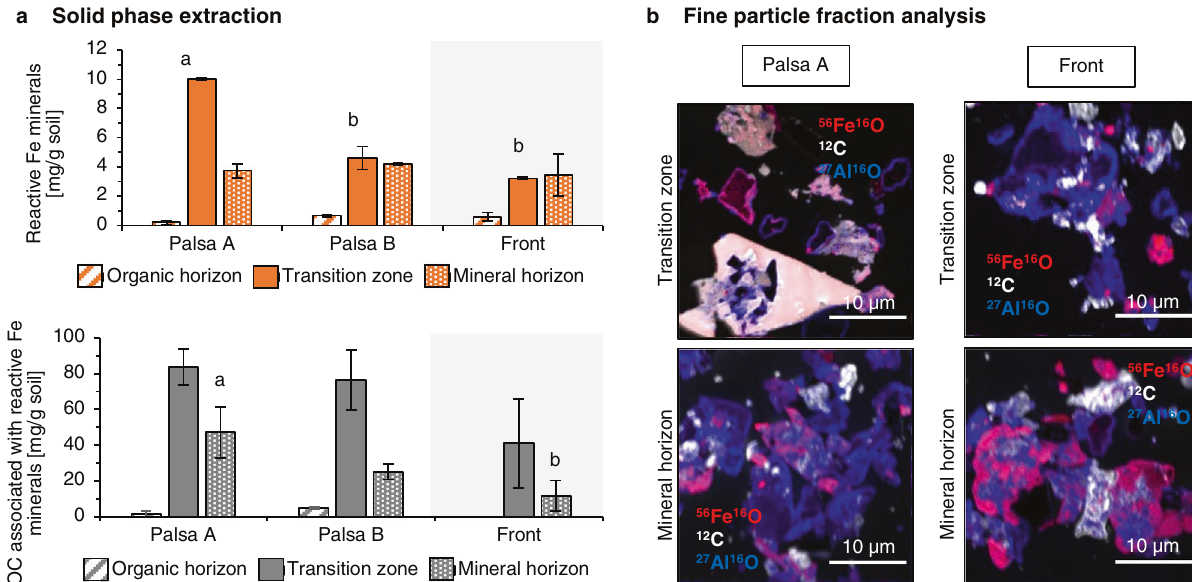
Fig. 3 Reactive iron (Fe) minerals and organic carbon (OC) associated with reactive Fe minerals from intact palsa to the collapsing front. a Reactive Fe minerals and associated OC in the solid phase of the bulk soil decrease from the intact palsa (Palsa A) towards the collapsing front. Values of reactive Fe minerals are the average of sodium dithionite citrate duplicate extractions, control corrected by sodium chloride bicarbonate extractable Fe (leachable Fe). Values of OC associated with reactive Fe minerals are the average of sodium dithionite citrate extractions, control corrected by subtraction of the citrate background and the sodium chloride bicarbonate extractable OC (leachable OC) (see Methods). Error bars of reactive Fe minerals represent a combined standard deviation of sodium chloride bicarbonate extractable Fe and sodium dithionite citrate extractable Fe. Errors of the Fe-associated carbon represent a combined standard deviation of the citrate blank, sodium chloride bicarbonate extractable OC and sodium dithionite citrate extractable OC. Different small letters above bars mean signi fi cant differences ( P < 0.05, one-way ANOVA: TukeyHSD test). b High spatial resolution analysis of Fe-OC associations by nanoSIMS in the fi ne particle fraction of the soil, displayed as 12 C − (white), 56 Fe 16 O − (red) and 27 Al 16 O − (blue) overlaid in a composite image. For the two end-members, Palsa A and collapsing front, four particles of the fi ne fractions of each layer were analyzed by correlative SEM and nanoSIMS, all showing the same spatial distribution of Fe, C and Al as shown by the four representatives (Supplementary Figs. S14 and